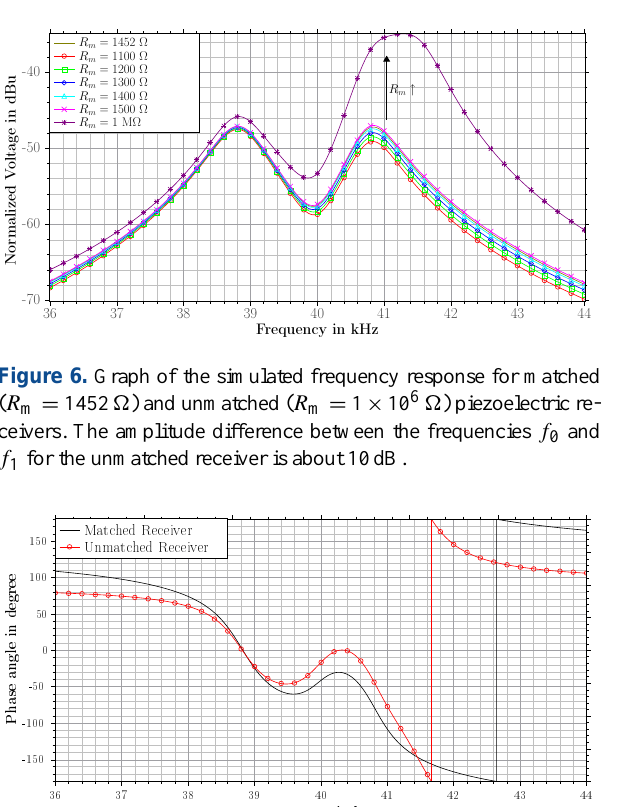
Figure 7. Graph of the simulated phase angle for matched ( R m = 1452 (cid:127) ) and unmatched ( R m = 1 × 10 6 (cid:127) ) piezoelectric receivers. The angle at the frequency f 0 = 38 . 8kHz remains constant and the angle for the frequency f 1 = 40 . 8kHz rotates by 30 ◦ .